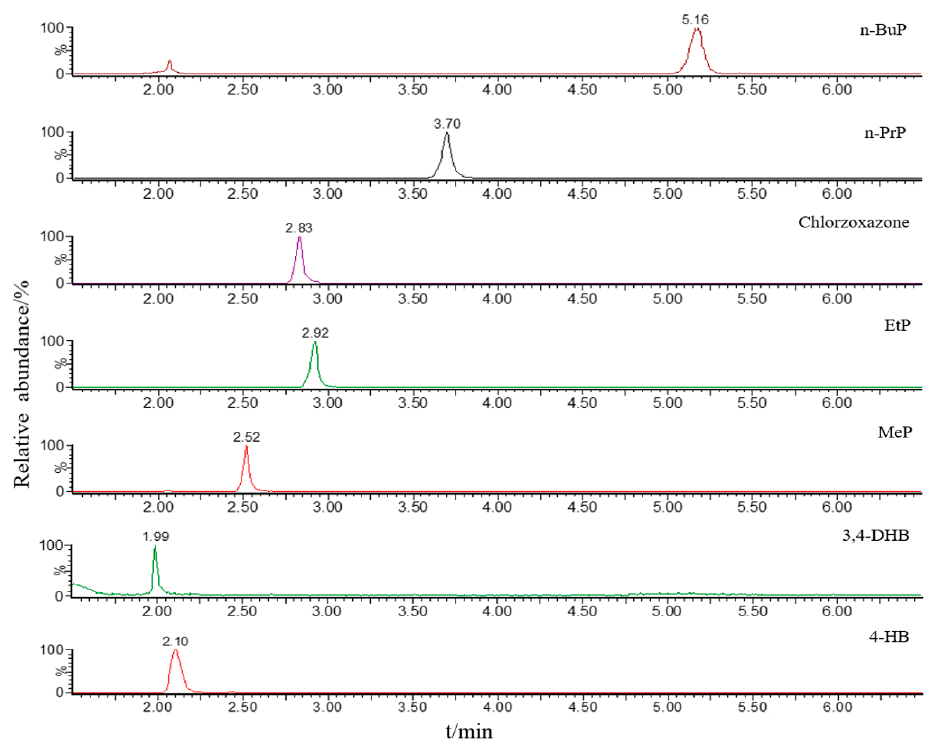
Figure 1. Chromatograms of four parabens (MeP, EtP, n-PrP, and n-BuP), two metabolites (4-HB and 3,4-DHB), and internal standard (Chlorzoxazone) at the concentration of 50 ng/mL obtained by MRM mode. Table 2. Linear equations, measurement ranges, correlation coefficients, limits of detection of parabens and their